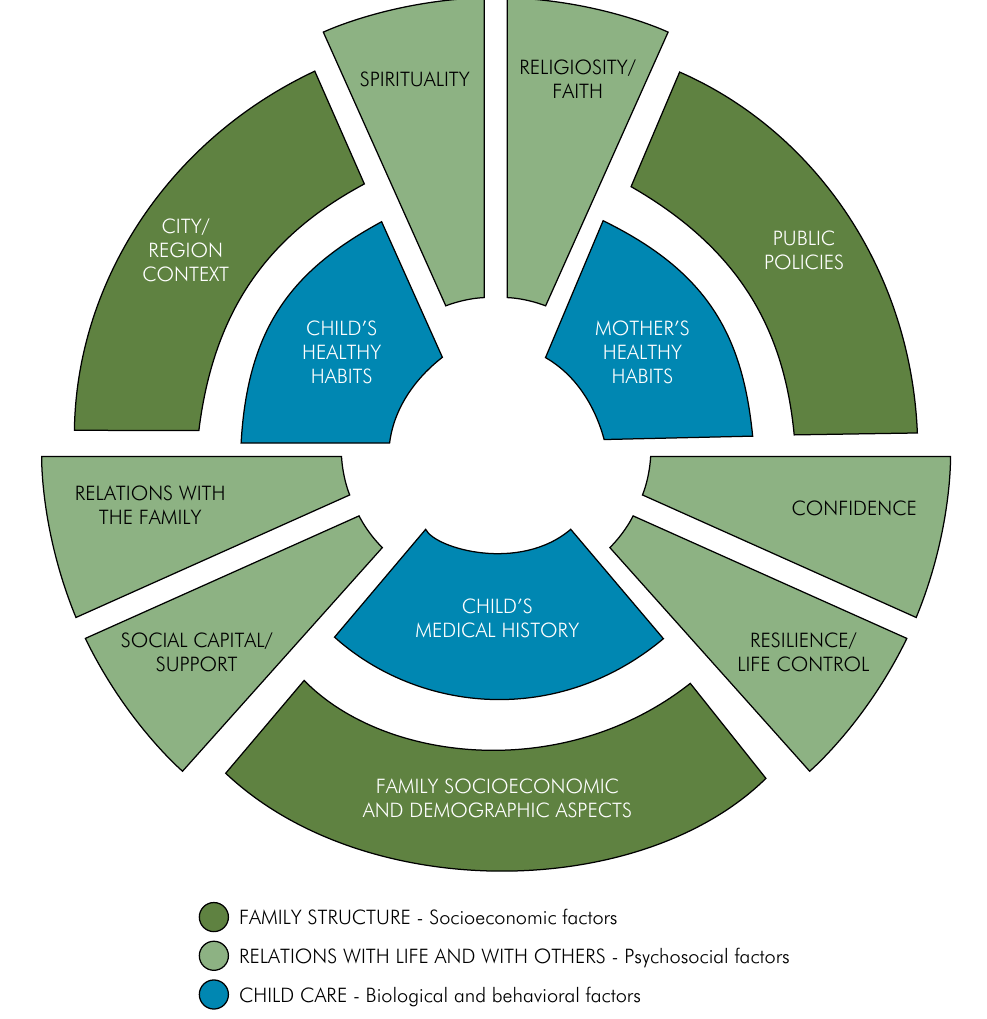
Figure. Hierarchized model proposed for the determination of the absence of dental caries experience in 5-year-old